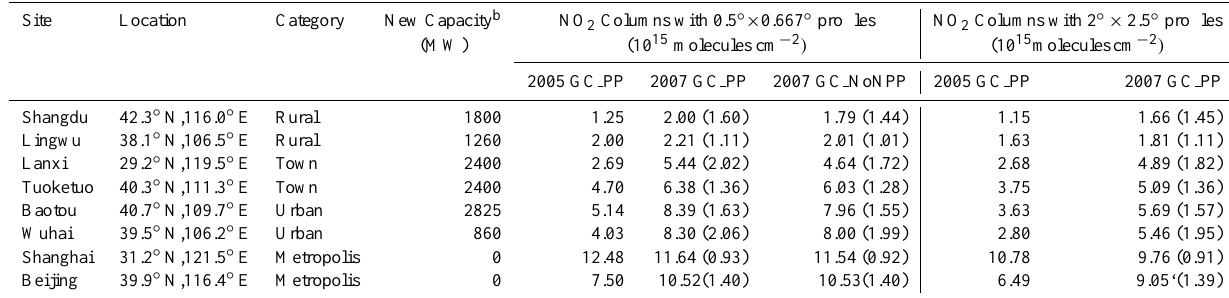
Table 4. Summer average OMI NO 2 columns derived with different a priori NO 2 profiles over various sites a